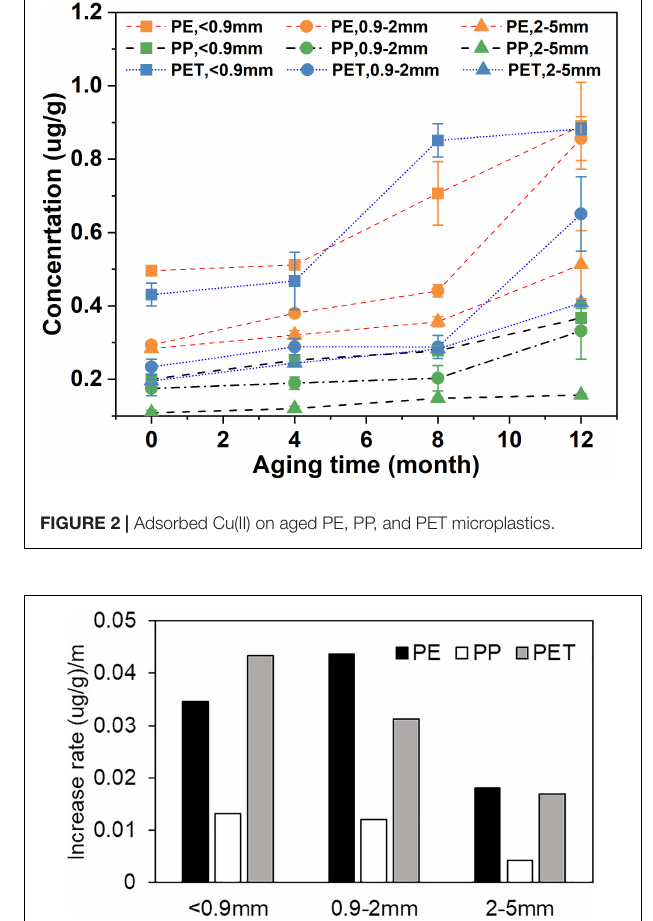
FIGURE 3 | Aging-derived increase rate [( µ g/g)/m] of adsorbed Cu(II) on aged